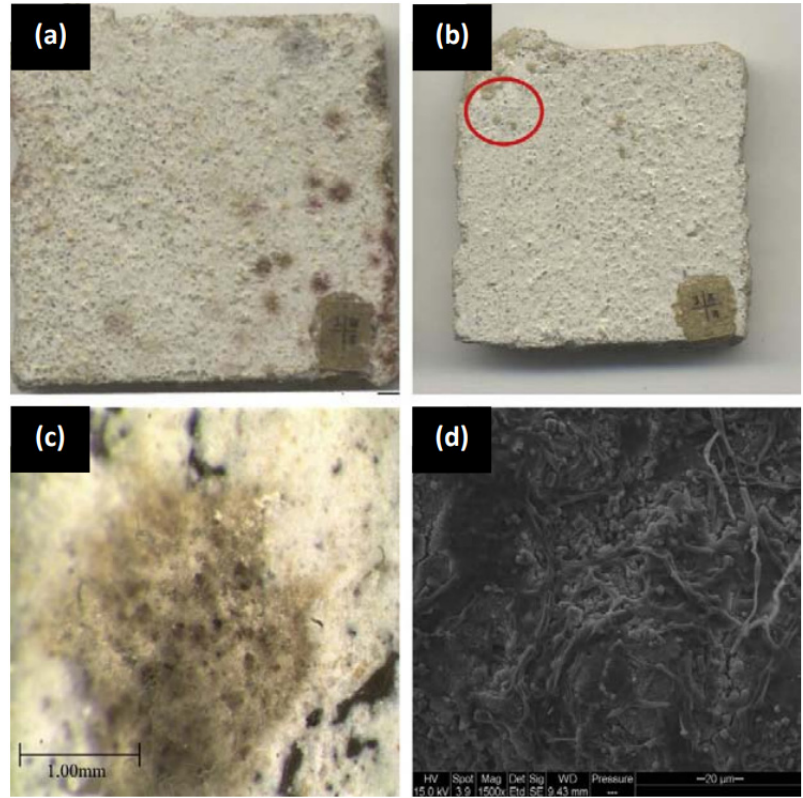
Figure 8. Fouling of tiles inoculated with eight fungal isolates incubated with 20% PDB and exposed to artificial sunlight. ( a ) Multi ‐ colored fouling of a tile composed of non ‐ photocatalytic cement, ( b ) fouling of a tile composed of cement containing TiO 2 , red circle indicates location of growth, ( c ) stereomicroscope image of tan ‐ colored fouling on the photocatalytic tile, ( d ) ESEM image of fouling on the photocatalytic tile. Reprinted with permission from Ref. [63]. Copyright 2009, Elsevier.